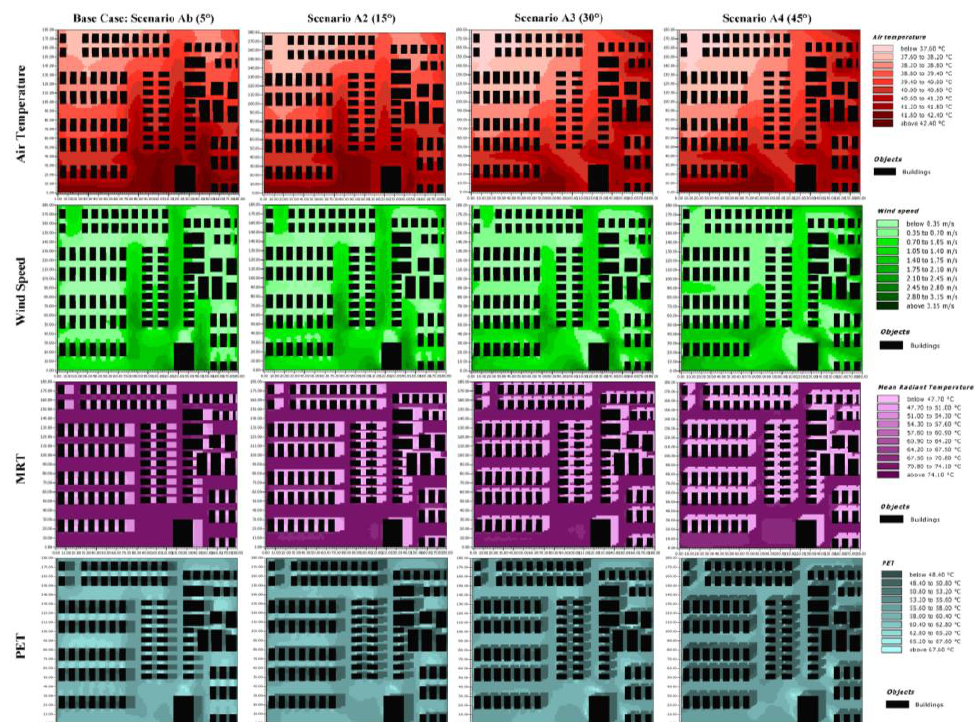
Fig. 4. Air temperature, wind speed, MRT and PET of scenario Ab, A2, A3 and